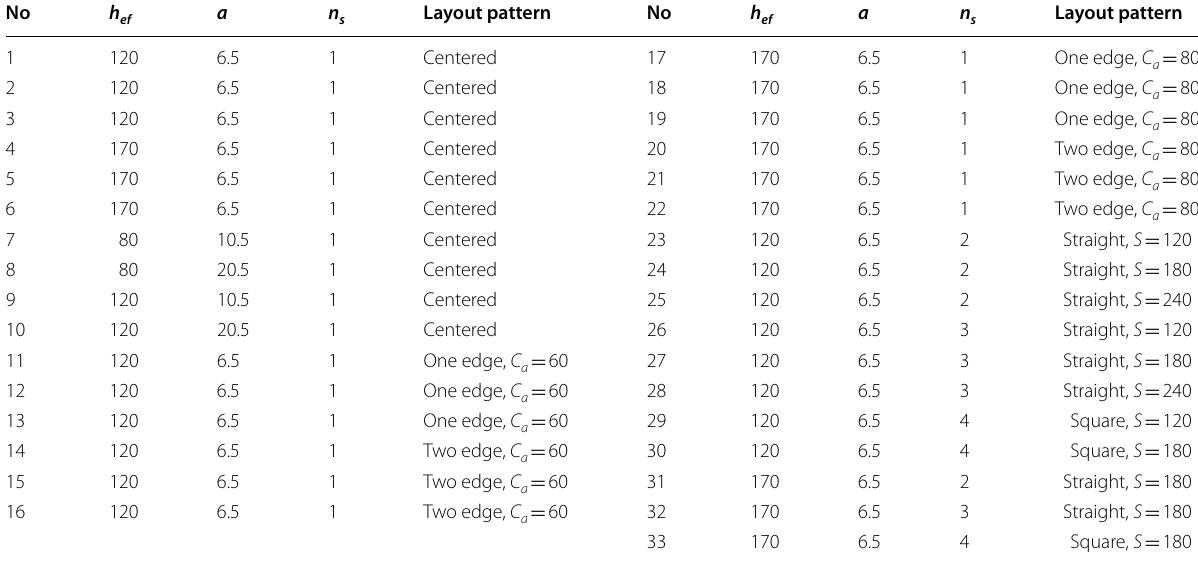
Table 1 Geometrical parameters of test specimens (Unit: mm).